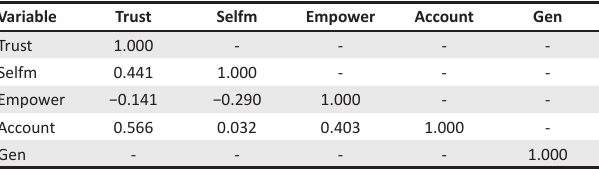
use of methods from which valid inferences can be drawn TABLE 5: The PHI matrix of the intercorrelations between the group factors.